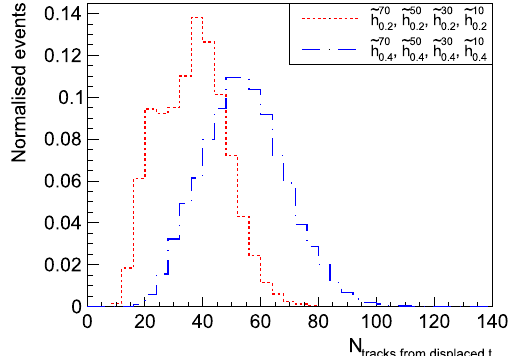
Fig. 30 Longitudinal impact parameter d z of the top quarks in the ˜ h 2 - like case with m ˜ χ 0